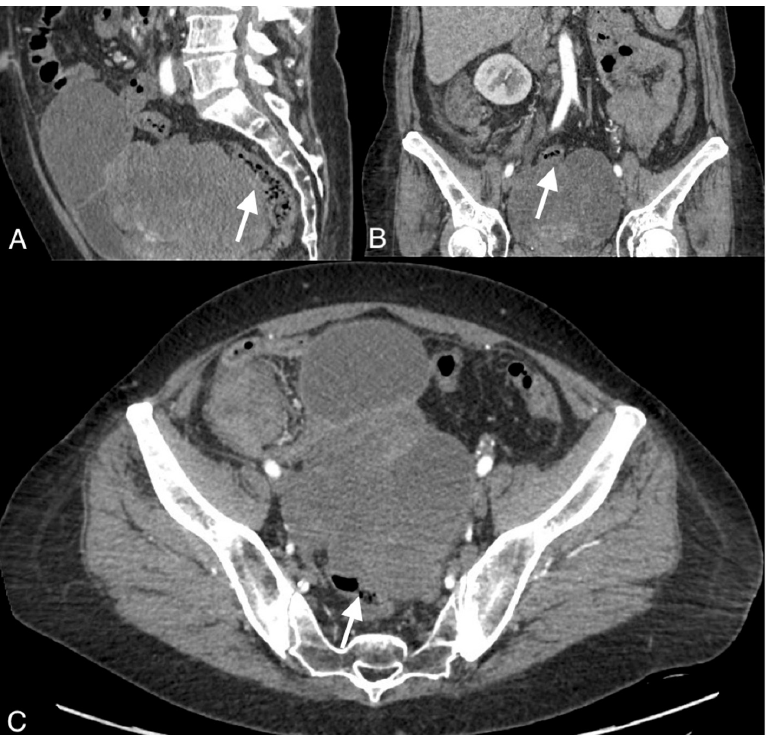
Figure 2. Images of a 54-year-old patient with an ovarian cancer recurrence in the form of the fistula between the tumor and rectum. CT obtained in the coronal ( A ), sagittal ( B ), and axial plane ( C ) shows large pelvic tumor with adjacent rectum.